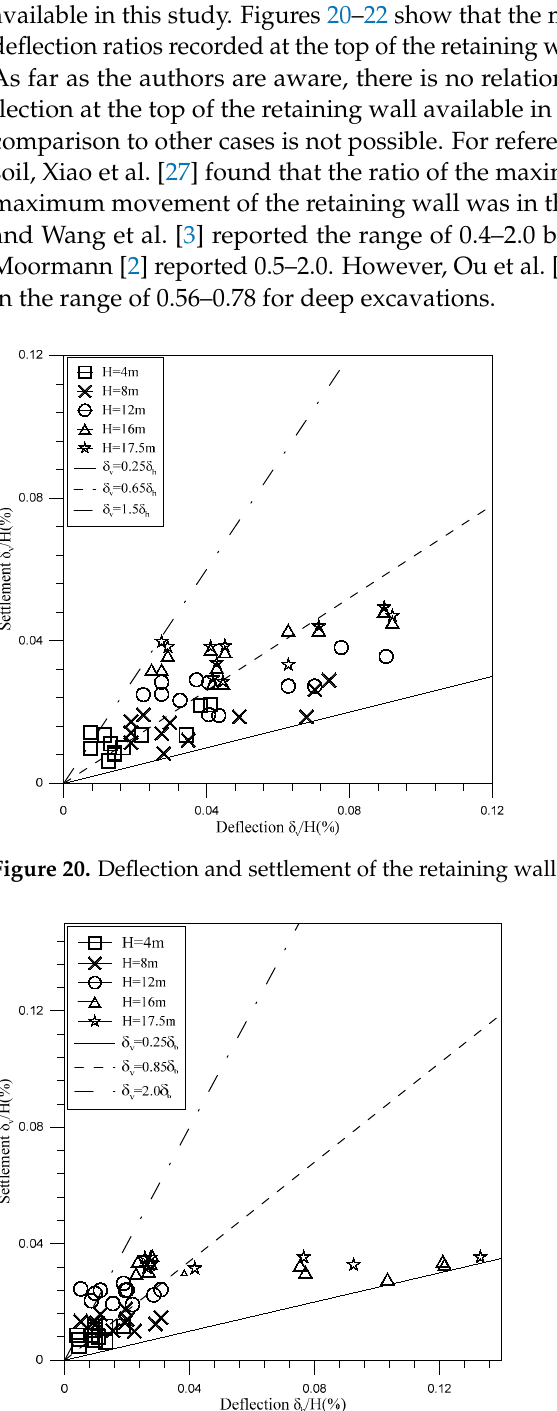
Figure 22. Deflection and settlement of the retaining wall (nodes 23–31).